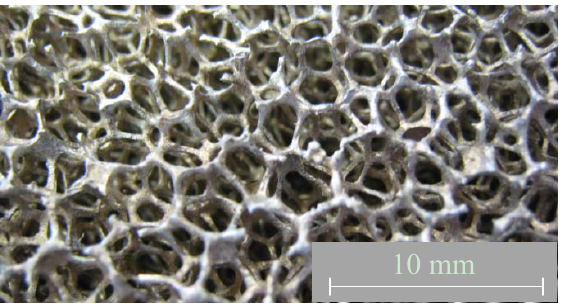
Figure 1. Open-cell metal